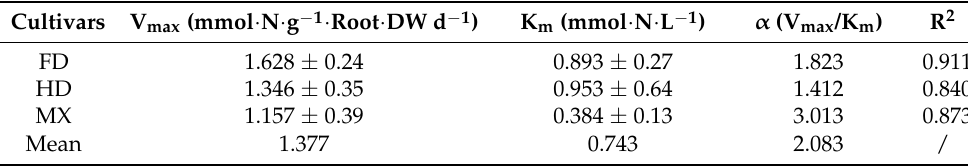
Table 2. Comparison of NH 4+ –N absorption dynamics parameters of roots in three different